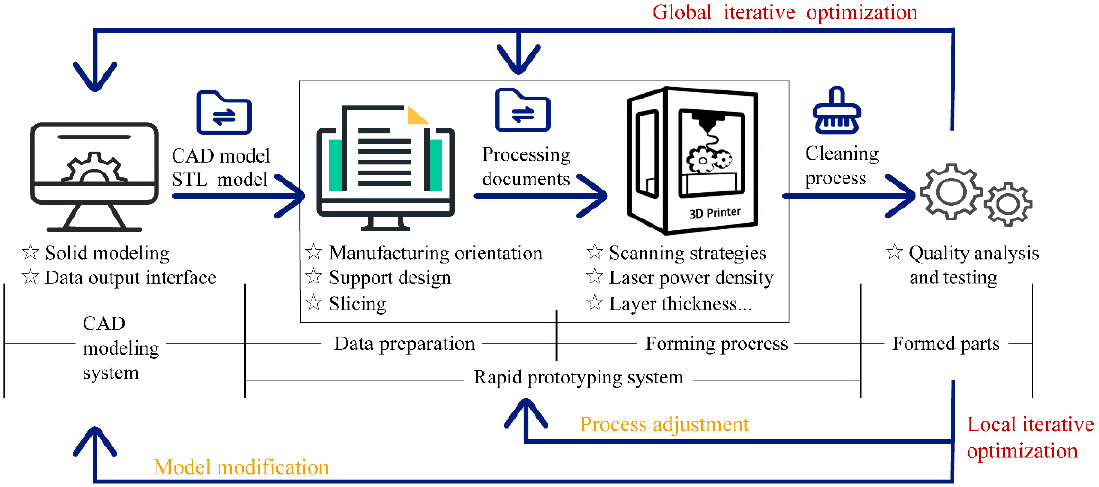
Figure 1. Process flow chart of AM.